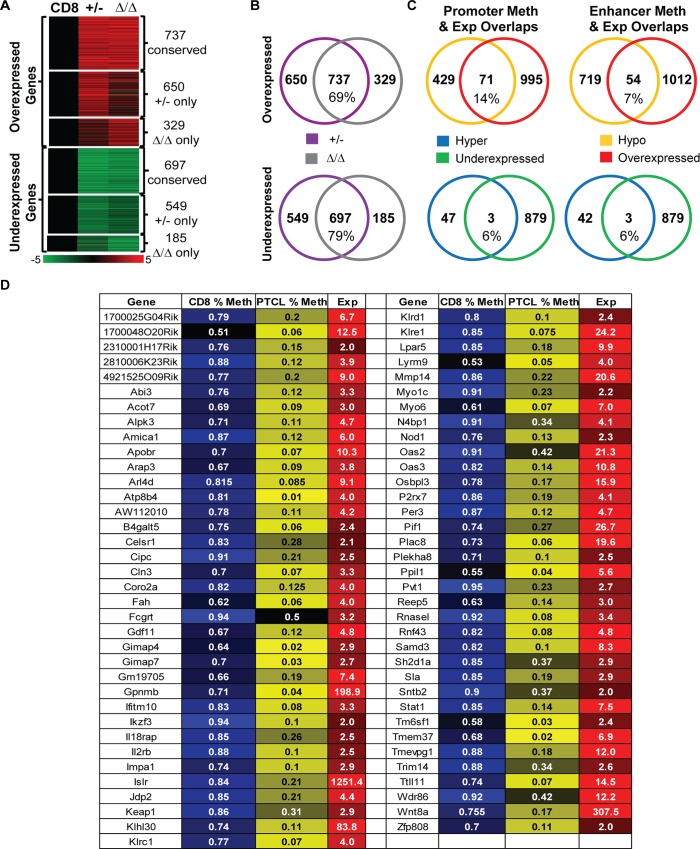
Gene expression is deregulated in Dnmt3aΔ/Δ PTCL.(A) Heat map of RNA-seq global expression data displaying differentially expressed genes in Dnmt3a+/- and Dnmt3aΔ/Δ PTCL (≥2 fold change and a p-value < 0.05) relative to wild-type CD8+ cells, 737 genes were overexpressed and 697 genes were underexpressed in both Dnmt3a+/- and Dnmt3aΔ/Δ PTCL. 650 overexpressed and 549 underexpressed genes were specific to Dnmt3a+/- PTCL, whereas 329 overexpressed and 185 underexpressed genes were only observed in Dnmt3aΔ/Δ PTCL. A color bar displays fold change in gene expression with overexpressed shown in red and underexpressed in green. (B) Venn diagram showing overlap in over- and underexpressed genes between Dnmt3a+/- PTCL (purple) and Dnmt3aΔ/Δ PTCL (gray). (C) (left) Venn diagram showing overlap between the number of differentially expressed genes (red = overexpression; green = underexpression) and the number of differentially methylated gene promoters (yellow = hypomethylation; blue = hypermethylation) in Dnmt3aΔ/Δ PTCL relative to wild-type CD8+ controls. (right) Overlap between differentially expressed genes and differentially methylated enhancers regions. (D) List of genes hypomethylated and overexpressed in Dnmt3aΔ/Δ PTCL (HOT genes). Promoter methylation for wild-type CD8+ cells and Dnmt3aΔ/Δ PTCL is shown in blue and yellow, respectively. Corresponding changes in gene expression for Dnmt3aΔ/Δ PTCL relative to control CD8+ samples are shown in red.